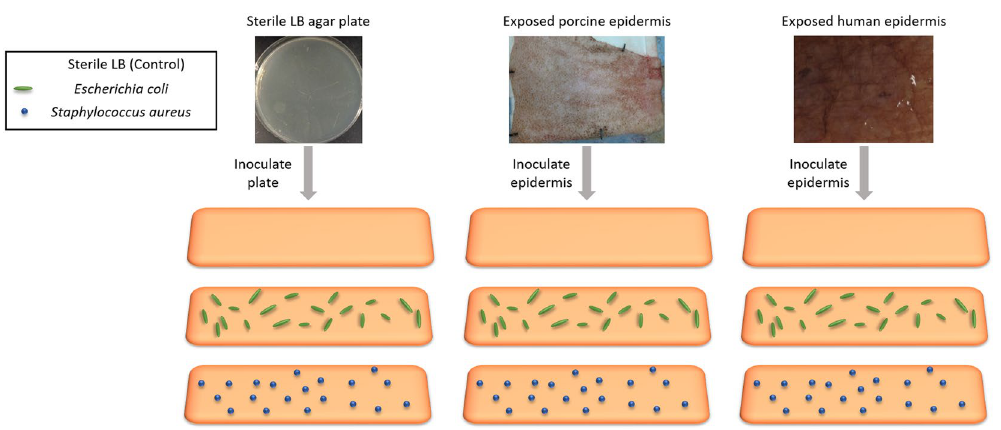
Figure 2. Experimental setup. Experimental design was based off of detecting two species of pathogenic bacteria from three surfaces. Lysogeny broth - Miller (LB-Miller) was used a control to directly compare to inoculations of bacteria in the same media. E. coli , S. aureus , and the sterile LB control were individually inoculated on each of three surfaces, LB agar plates, porcine epidermis, and human cadaveric epidermis. While the schematic representations shows that all samples had only the bacteria added via inoculation on them, porcine epidermis and human epidermis both have natural, commensal bacteria on their surfaces, but LB agar is sterile and should contain no additional bacteria on the